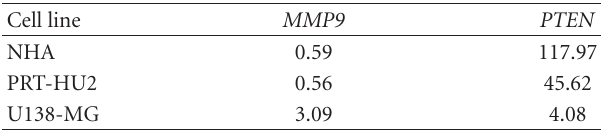
Table 4: MMP9 and PTEN absolute quantitative expression in di ff erent human normal (NHA) and glioma (PRT-HU2 and U138- MG) cell lines. Expression is indicated in